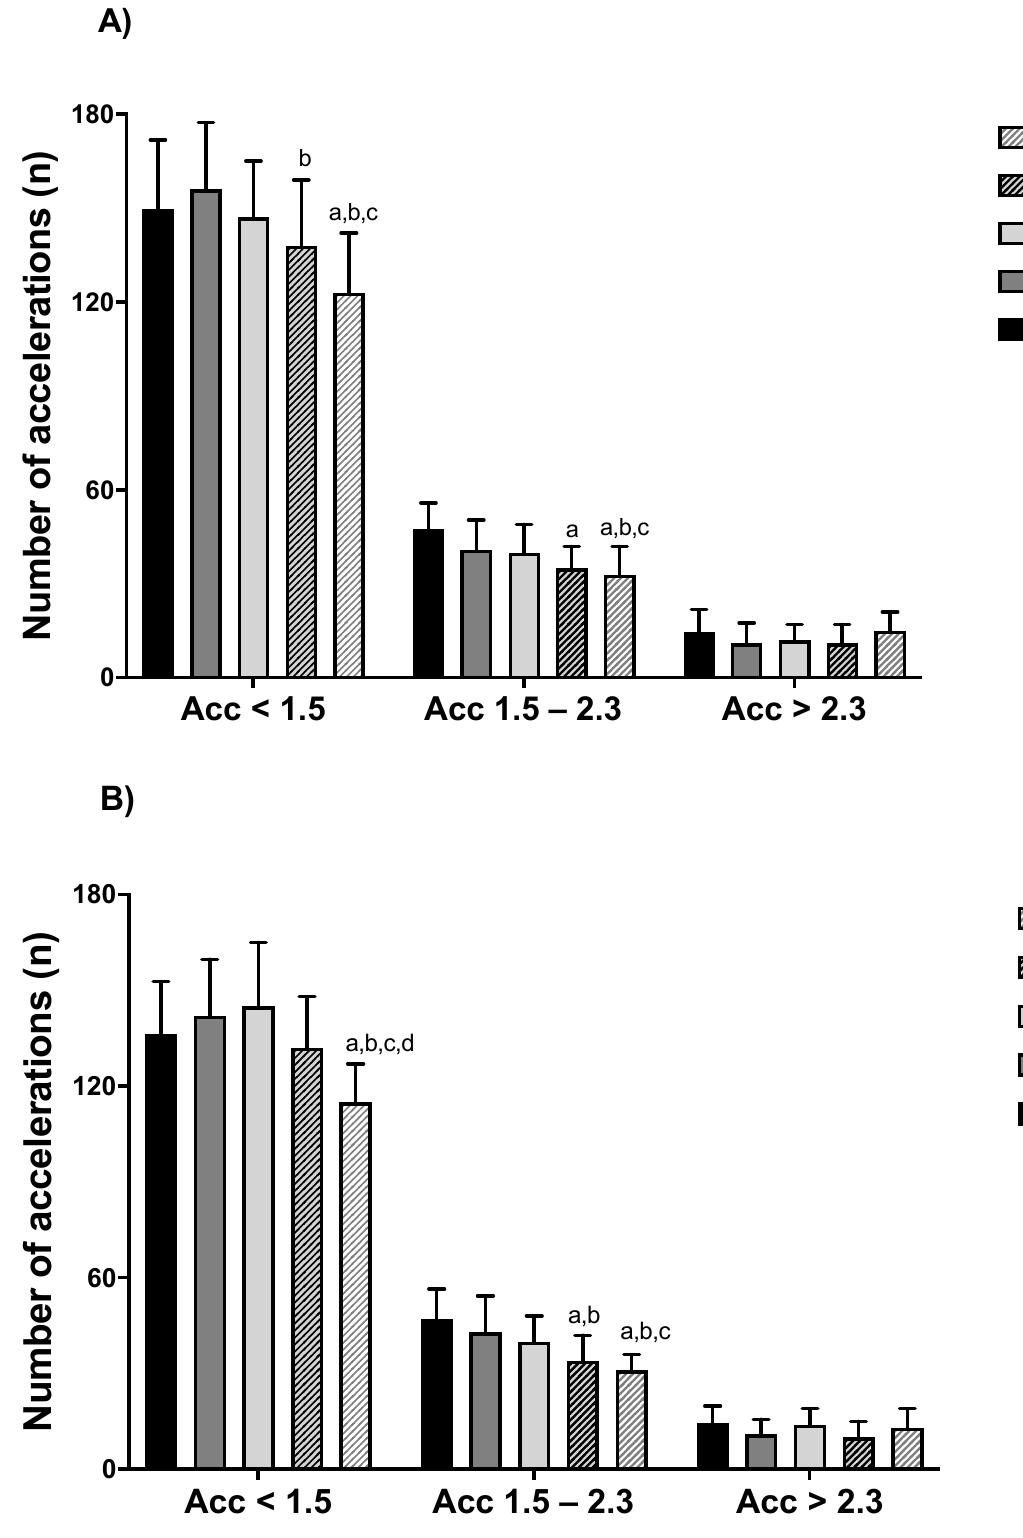
Figure 2. Number of accelerations in U9 ( A ) boy and ( B ) girl handball players by game formats. S3 + 1: small size, 3 v 3 + offensive goalkeeper; S4: small size, 4 v 4; M4: medium size, 4 v 4; M5: medium size, 5 v 5; L5: large size, 5 v 5. a denotes significant differences compared to S3 + 1; b to S4; c to M4; d to M5 ( p ≤ 0.05).